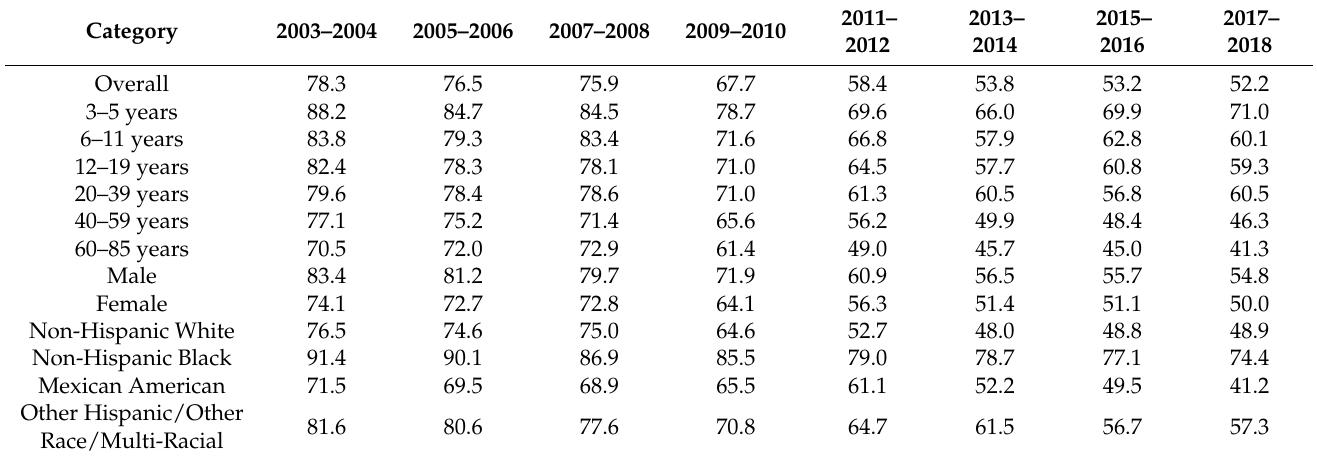
Table A2. Weighted Detection rates for serum cotinine by NHANES survey cycle overall and for each demographic subgroup from 2003 to 2018.